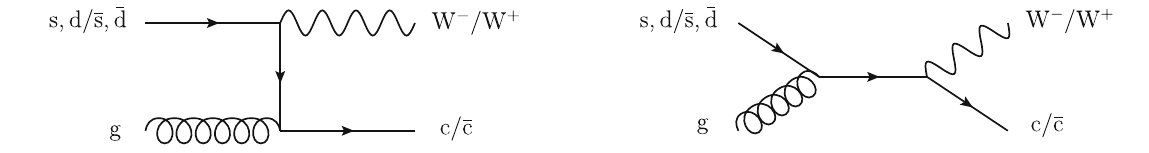
Fig. 1 Leading order diagrams for the associated production of a W boson and a charm